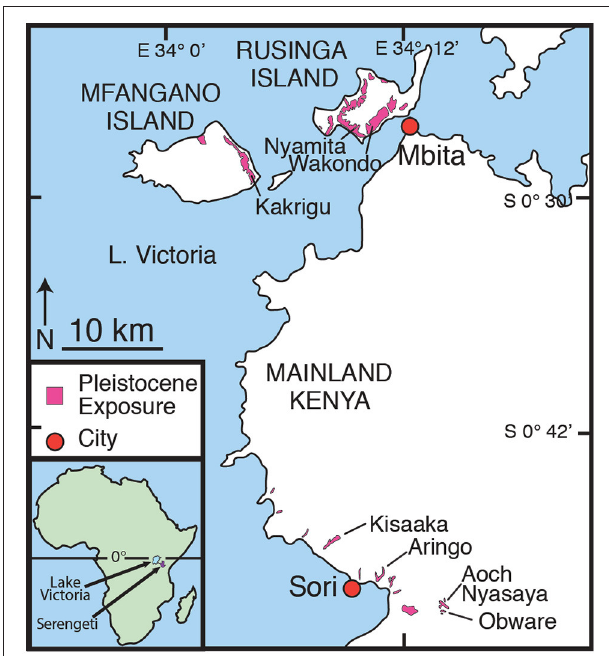
FIGURE 1 | Location of Karungu and Mfangano and Rusinga Islands in western Kenya along the eastern shore of Lake Victoria. Areal extent of Late Pleistocene outcrops in this study is shown in pink. Inset map shows the locations of Lake Victoria and the Serengeti Ecosystem in East